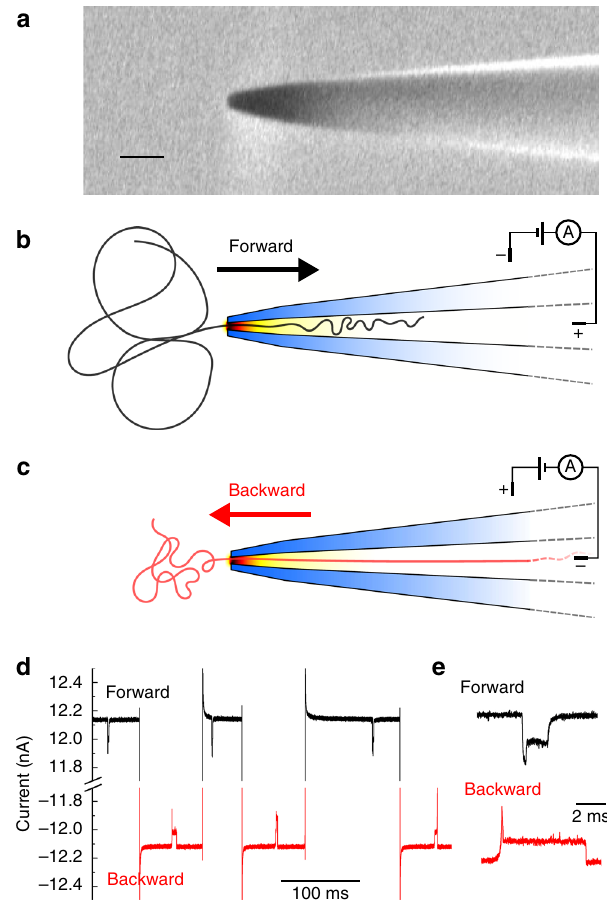
Fig. 1 Set-up for DNA translocations and examples of the ping-pong experiment. a Example scanning electron microscope image showing the outer dimensions of the conical nanopore. Scale bar = 100 nm. b Forward translocation: DNA enters the nanopore from the open reservoir. c Backward translocation: DNA exits the nanopore and passes into the reservoir. d Ionic current trace showing multiple translocations of a single DNA molecule which is moved forward and backward through the pore by repeatedy switching the polarity of the 600 mV potential. e Current